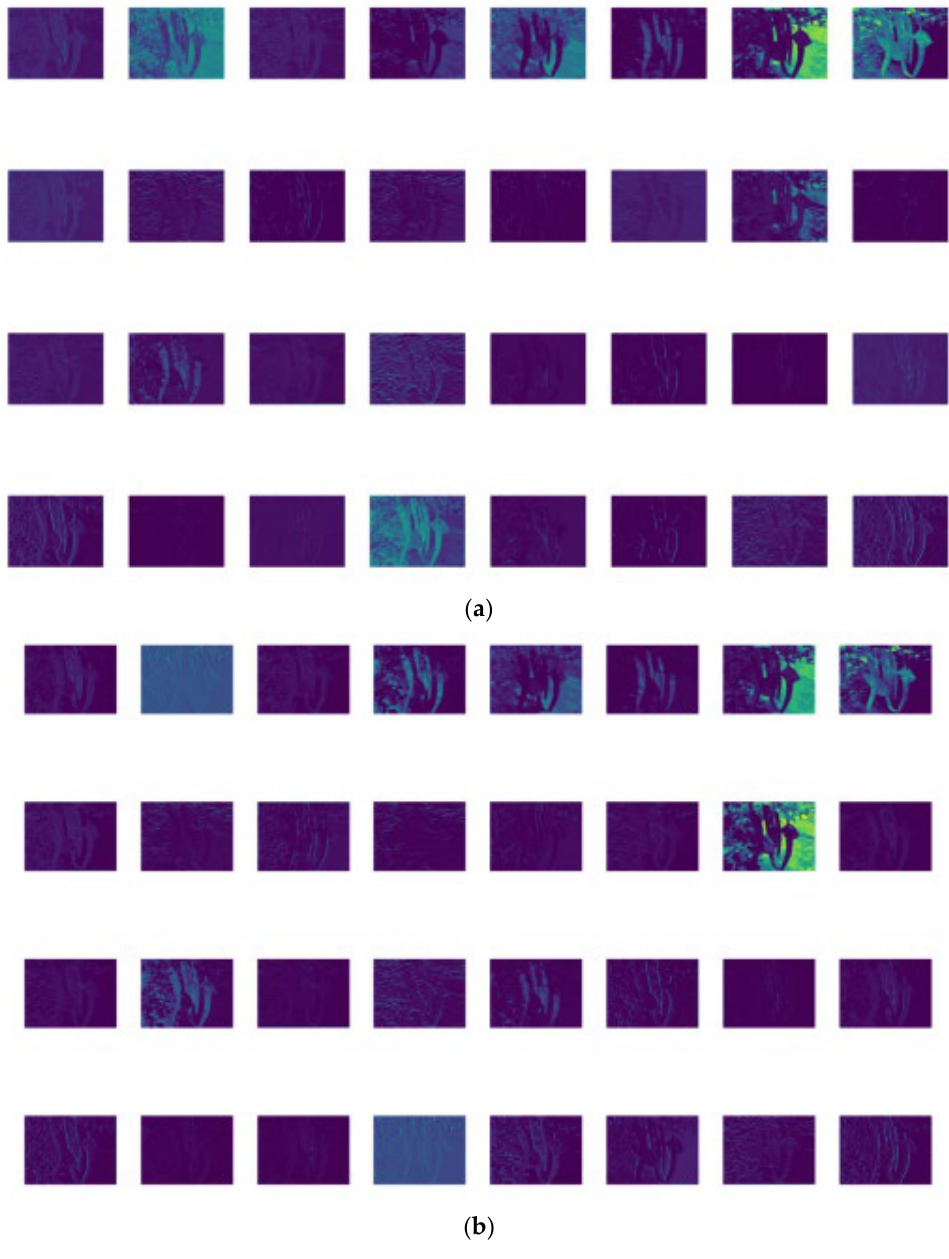
Figure 12. ( a ) Feature map extracted by YOLOv5s; ( b ) GNPD-YOLOv5s used to extract feature map.